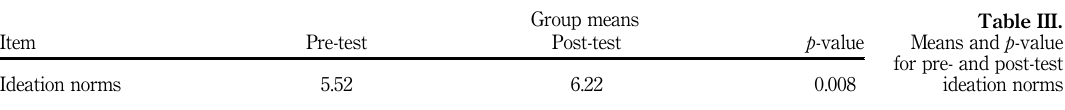
Table III. Means and p